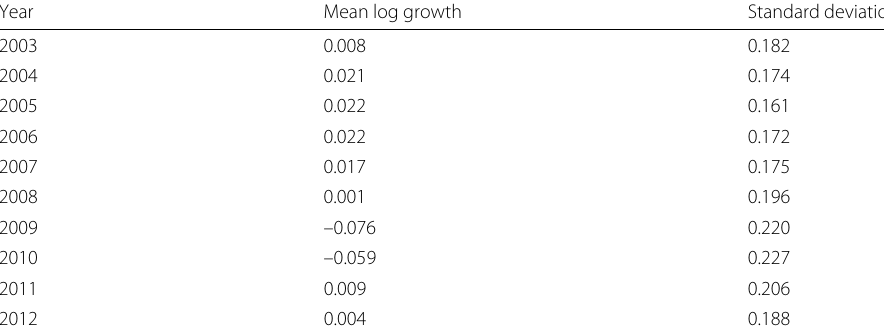
Table 1 Average log growth rate of firms and standard